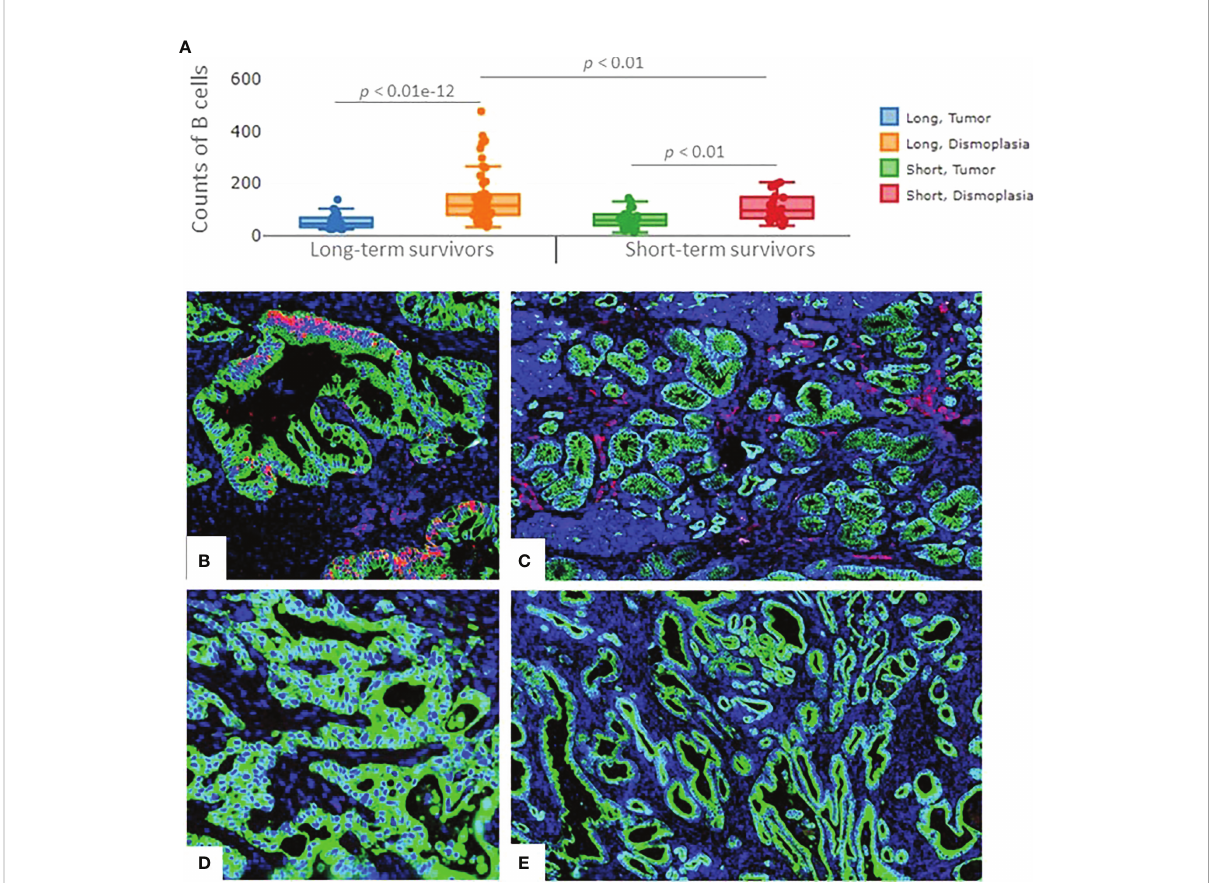
FIGURE 4 The expression of B cells in the validation cohort of samples. (A) Signi fi cant higher in fi ltration of B cells was found in the desmoplastic areas of the long-term survivors, compared to desmoplastic areas of short-term survivors. In fi ltration of B cells was found to be higher in desmoplasia compared to tumor-rich areas in both groups. Each dot represents an ROI, the middle line presents the average of the normalized expression of CD20 antibody, long-term survivors n=12, short-term survivors n=10. Fluorescent immunohistochemistry staining of PDAC samples (Mixed Linear Model test). (B) CD20 cells (B cells) in fi ltrated in-between (within) the tumor cells, (C) and in the desmoplastic areas of long-term survival PDAC samples. (D) negative staining of CD20 in-between (within) tumor cells, (E) Fewer B cells were found to in fi ltrate in the desmoplastic areas of short-term survival PDAC samples. Green color: Pan Cytokeratin, Red color: CD20, blue color: